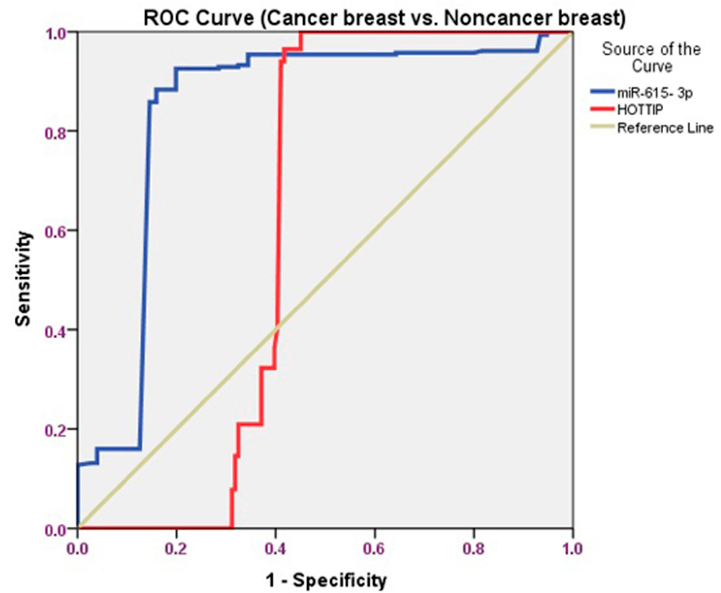
Figure 5. ROC curve analysis of the serum HOTTIP and miR-615-3p for distinguishing patients BC against those without BC (FA+ healthy with BC against those without BC (FA+ healthy persons).